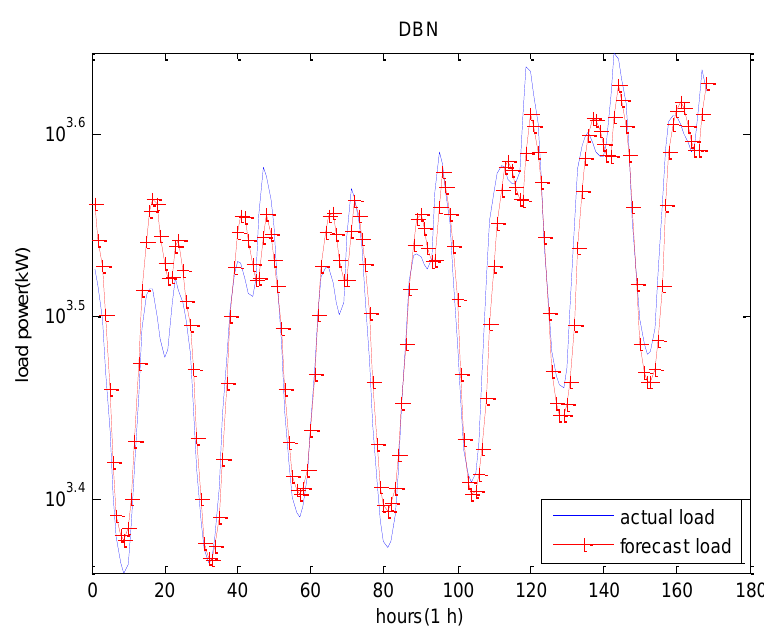
Figure 10. The forecast results of seven consecutive days using DBN model.